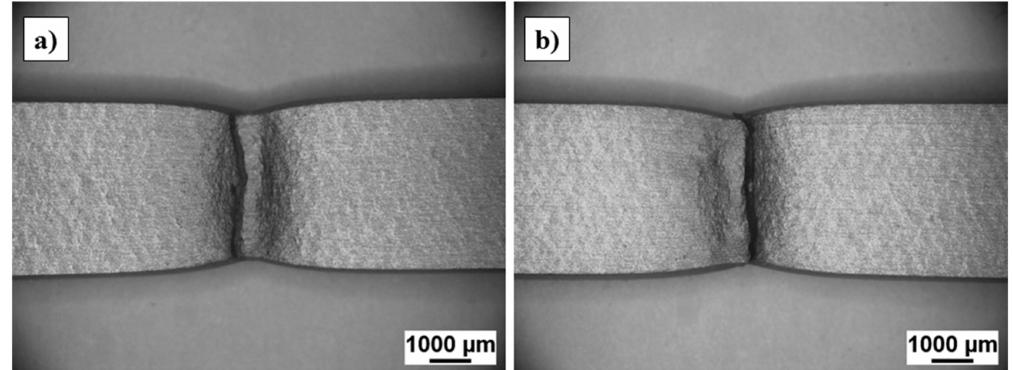
Figure 12. Macrograph of LDSS 2404 sample after SSRT in air at 25 ◦ C ( a ) and in NACE TM-0177 solution at 25 ◦ C and pH 2.7, in the presence of 10 − 2 M S 2 O 3 2 − ( b